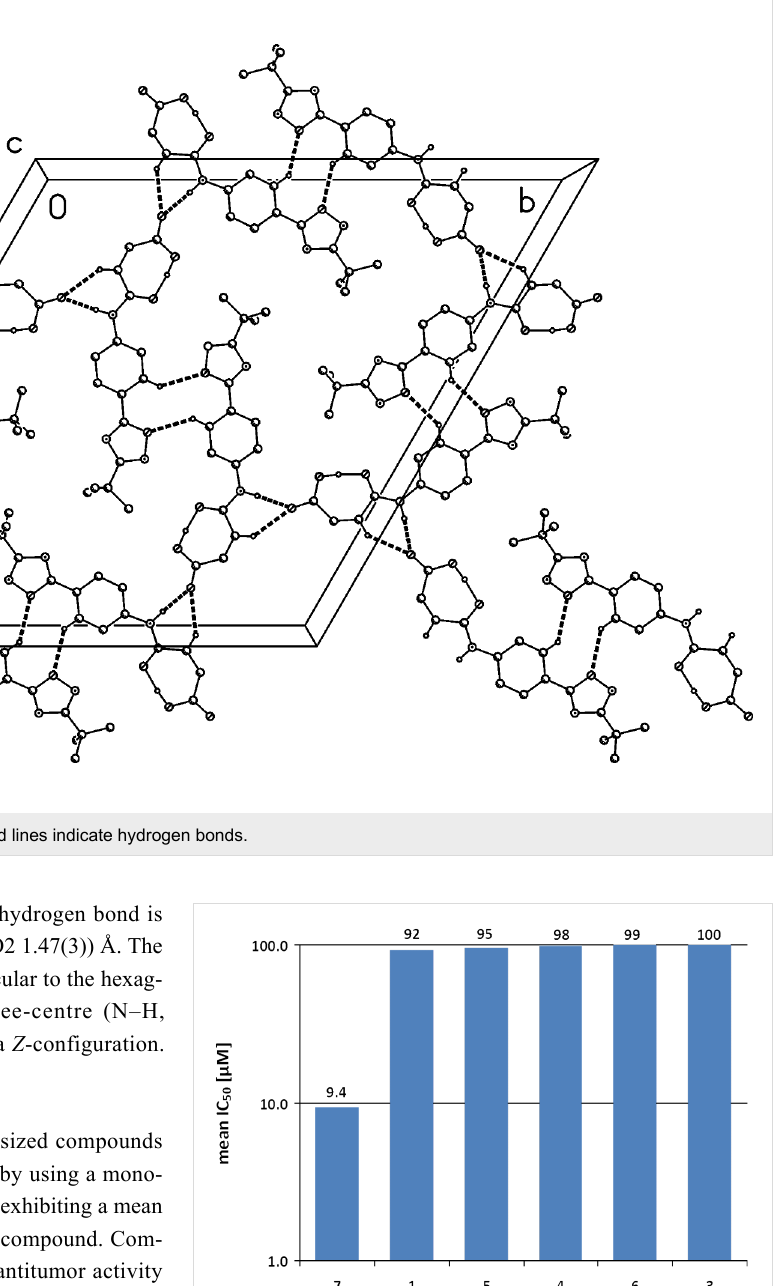
marked in green) and the range of activity among the cell lines (i.e., the IC 50 value of the most resistant cell line divided by the IC 50 value of the most sensitive cell line). Overall, a good anti- tumor potency (i.e., a mean IC 50 < 30 µM) combined with a good selectivity (i.e., a range of activity > 8 or at least 2 cell lines exhibiting above-average sensitivity) was obvious for compound 7